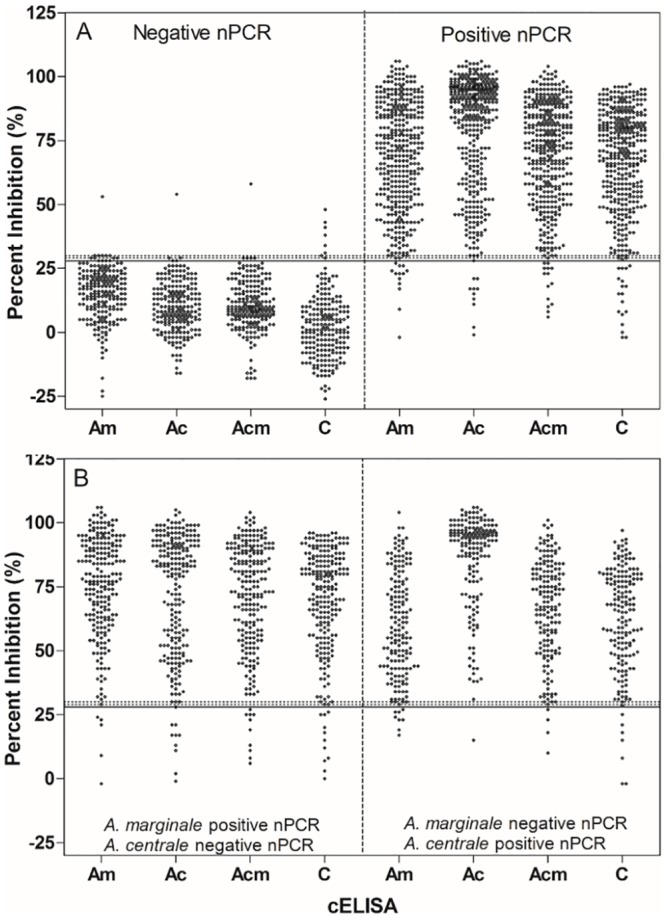
Percent inhibition results obtained by hcELISA-tMSP5m (Am), -tMSP5c (Ac), -tMSP5cm (Acm) and ccELISA (C).A) Anaplasma spp. nPCR negative and positive cattle, and B) A. marginale-infected (left) and A. centrale-vaccinated (right) cattle. The cut-off values for ccELISA and hcELISA are indicated with a solid and dotted line, respectively.